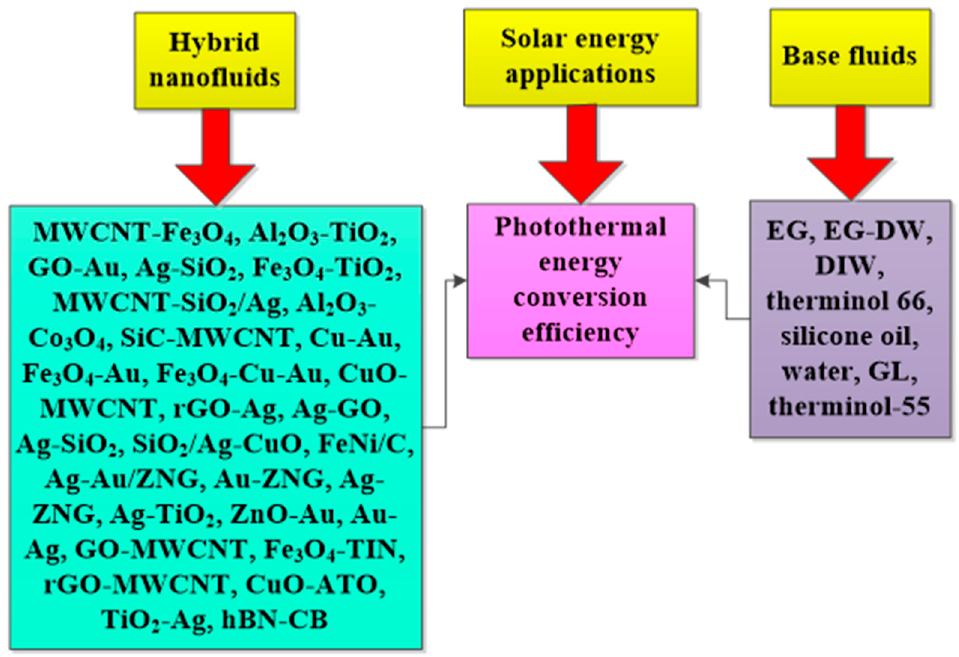
Figure 15. Hybrid nanofluids deployed for photothermal energy conversion efficiency studies.